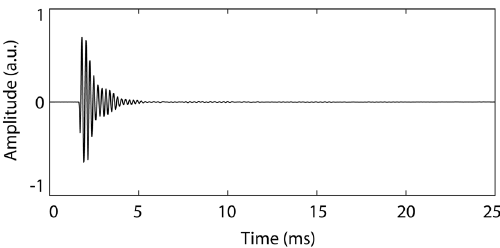
Figure 1. Waveform plot (left channel only) of recording of click emission made in front of the speaker. a.u. – arbitray units.